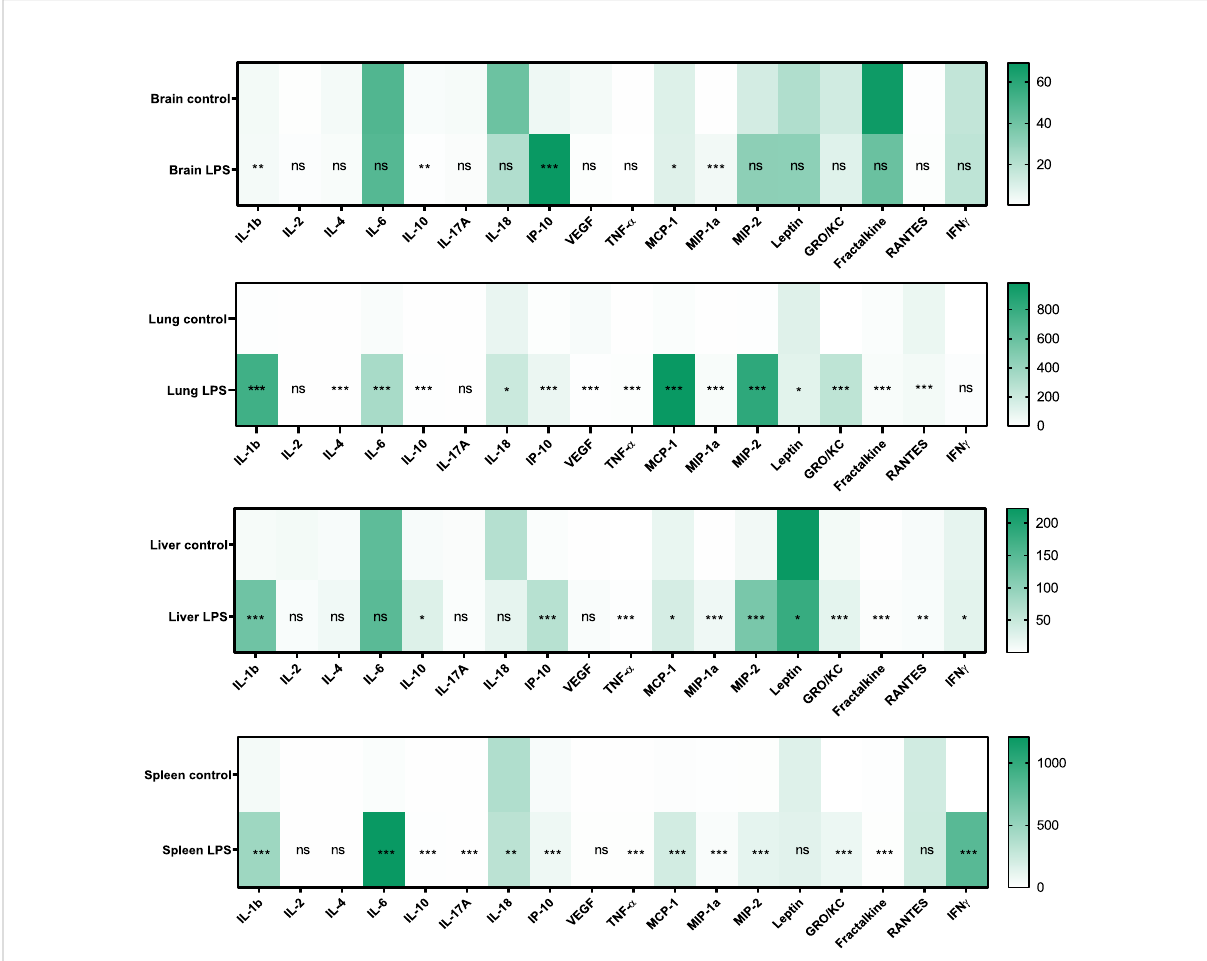
FIGURE 3 Expression of cytokines and chemokines in organ lysates. Changes in the expression (pg/mL) of various cytokines and chemokines in brain, lung, liver, and spleen lysates due to LPS treatment is shown (Control n=4, LPS n=14). Statistical analysis was performed using Mann-Whitney test to evaluate changes in tissue cytokines and chemokines between controls and LPS groups. p-values <0.01 are considered statistically signi fi cant. *p<0.05, **p<0.01, ***p<0.001, not signi fi cant